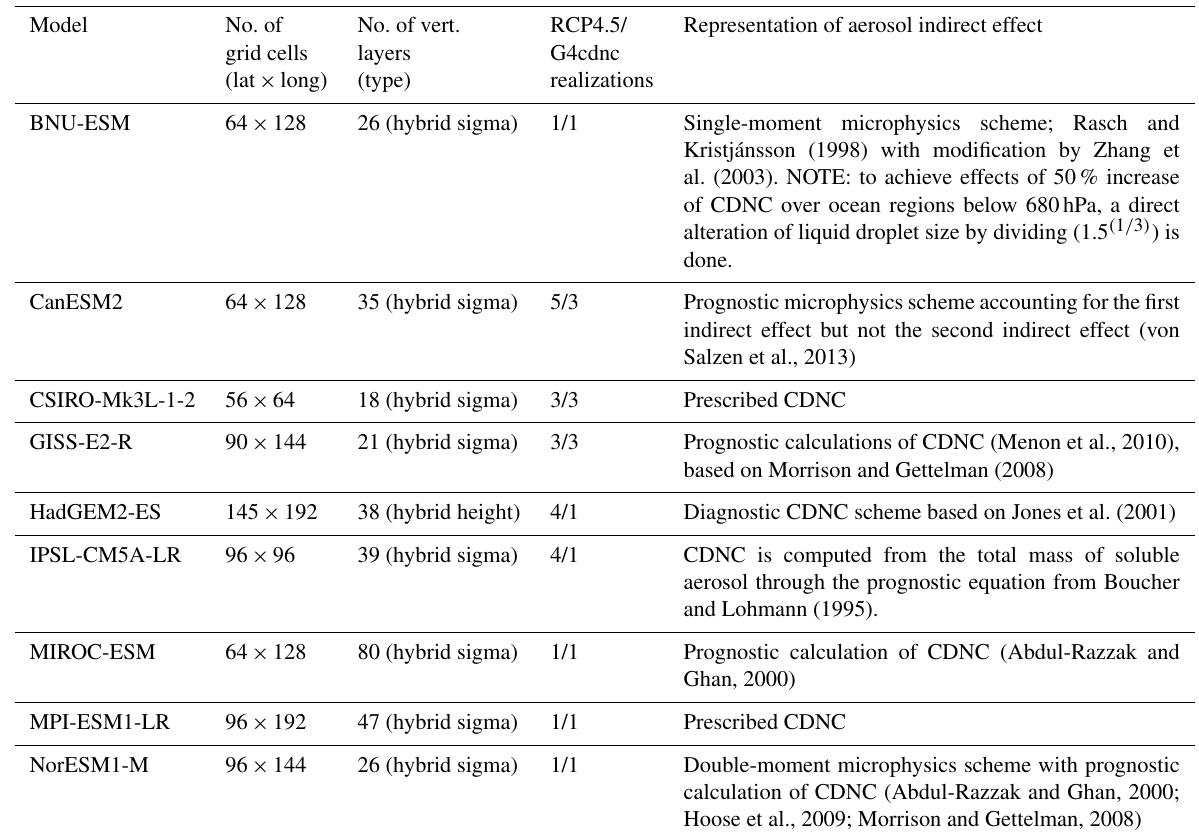
Table 1. Information on the contributing models, including resolution, number of realizations and their representation of the aerosol indirect effect. Model No. of No. of vert. RCP4.5/ Representation of aerosol indirect effect grid cells layers G4cdnc (lat × long) (type) realizations BNU-ESM 64 × 128 26 (hybrid sigma) 1/1 Single-moment microphysics scheme; Rasch and Kristjánsson (1998) with modification by Zhang et al. (2003). NOTE: to achieve effects of 50% increase of CDNC over ocean regions below 680hPa, a direct alteration of liquid droplet size by dividing (1.5 ( 1 / 3 ) ) is done. 5/3 indirect effect but not the second indirect effect (von Salzen et al., 2013) 3/3 Prescribed CDNC 3/3